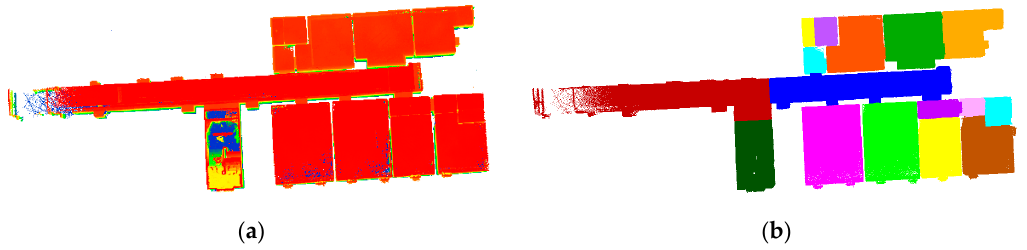
Figure 6. Point clouds before and after space labeling. ( a ) Original point clouds. ( b ) Point clouds after space labeling.